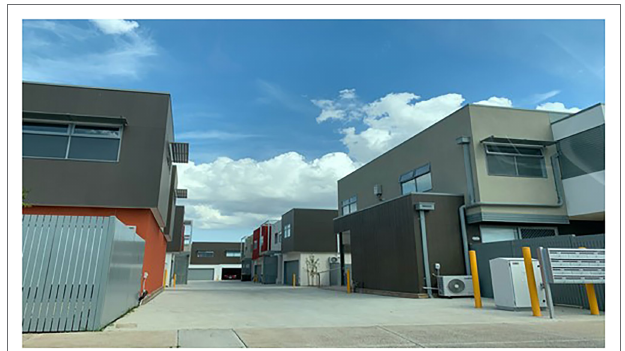
FIGURE 4 | The urban image shown for 40 s between the baseline and post-intervention SARTs in Study